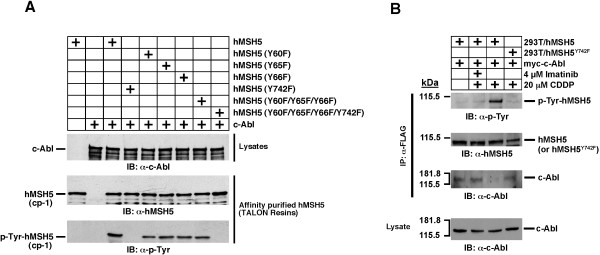
Identification of hMSH5 tyrosine residues that could be phosphorylated by c-Abl. (A) Six hMSH5 cp-1 mutants, harboring various Tyr-to-Phe mutations, were co-expressed with c-Abl in BL21 cells. The effects of these mutations on tyrosine phosphorylation were examined by immunoblotting analysis of affinity-purified hMSH5 cp-1 proteins with an α-p-Tyr antibody. (B) Tyr742 on hMSH5 was targeted by c-Abl kinase in response to cisplatin treatment, and hMSH5 of hMSH5 from c-Abl. 293T/f-hMSH5 and 293T/f-hMSH5Y742F cells were transfected with myc-c-Abl and treated with 20 μM cisplatin 48 hrs post-transfection. Cell lysates were prepared 6 hrs after cisplatin treatment, and α-Flag immunoprecipitates were analyzed by α-p-Tyr and α-c-Abl immunoblots. Four μM imatinib was used to inhibit c-Abl kinase activity.